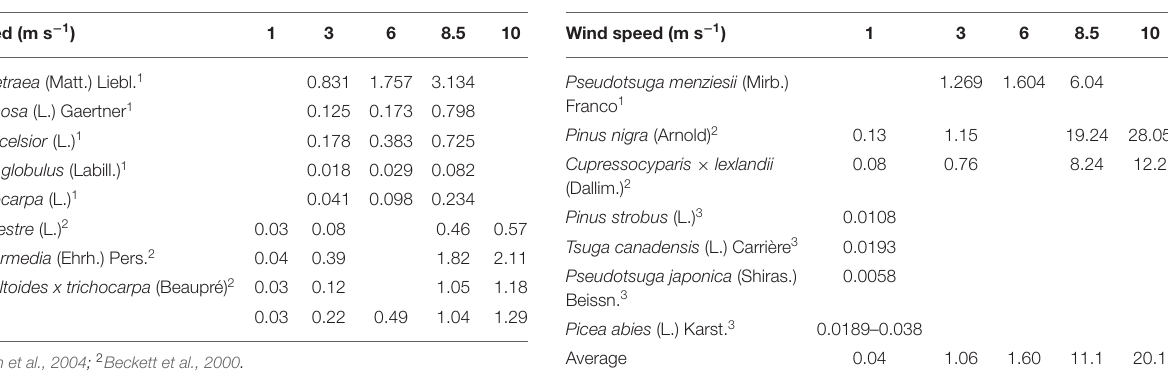
TABLE 2 | Deposition velocities for different wind-speed classes for coniferous trees derived from published data.